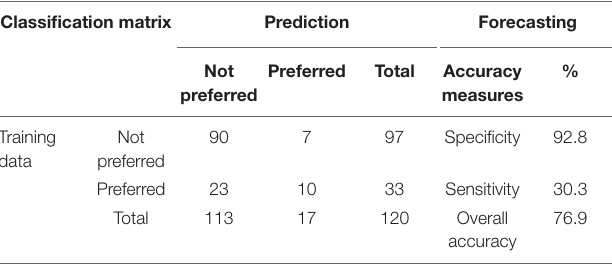
TABLE 4 | Classification matrix of CHAID for cognitive and affective activities. Classification matrix